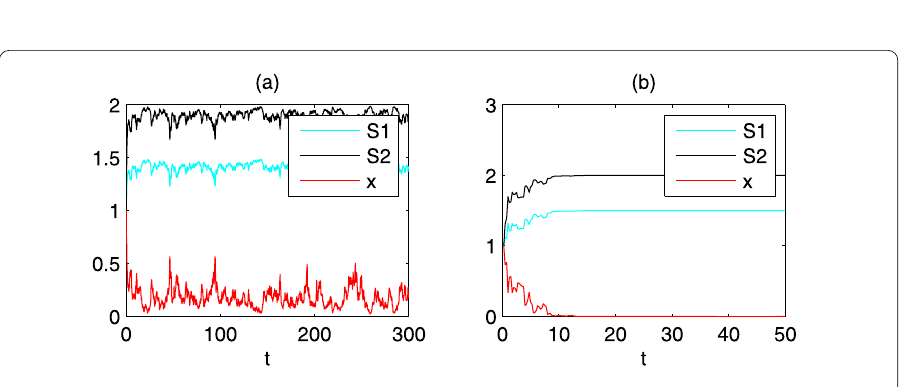
Figure 3 Time evolutions of the stochastic system with parameters S 10 = 1.5, S 20 = 2, Q = 1.45, δ 1 = 0.9, δ 2 = 1, a 1 = 1.6, a 2 = 1.6, μ 1 = 0.8, μ 2 = 0.8, σ 1 = 0.4, σ 2 = 0.4, r = 0.1, k = 1, g = 0.8, h = 1, m = 0.2, T = 1. ( a ) Time series for S 1 ( t ), S 2 ( t ), x ( t ) with parameters u = 0.1, R = 1.0135. ( b ) Time series for S 1 ( t ), S 2 ( t ), x ( t ) with parameters u = 1.1, R ∗ 4 =